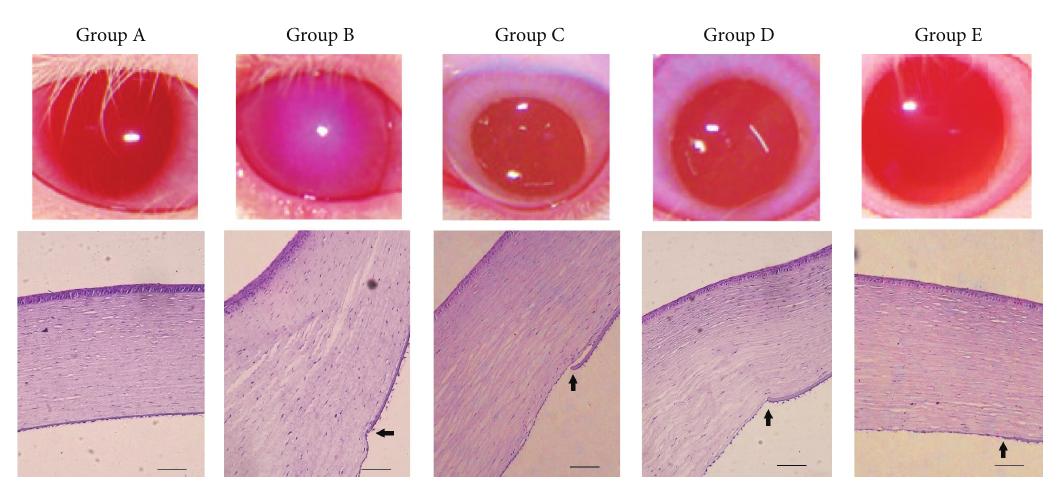
Figure 1: Anterior segment photographs (upper) and corneal photomicrographs (lower, H&E stain; original magnification × 200, bar = 100 𝜇 m) of rabbits in each group at 15 days postoperatively. Arrows show the edges of the Descemet membrane in eyes after descemetorhexis